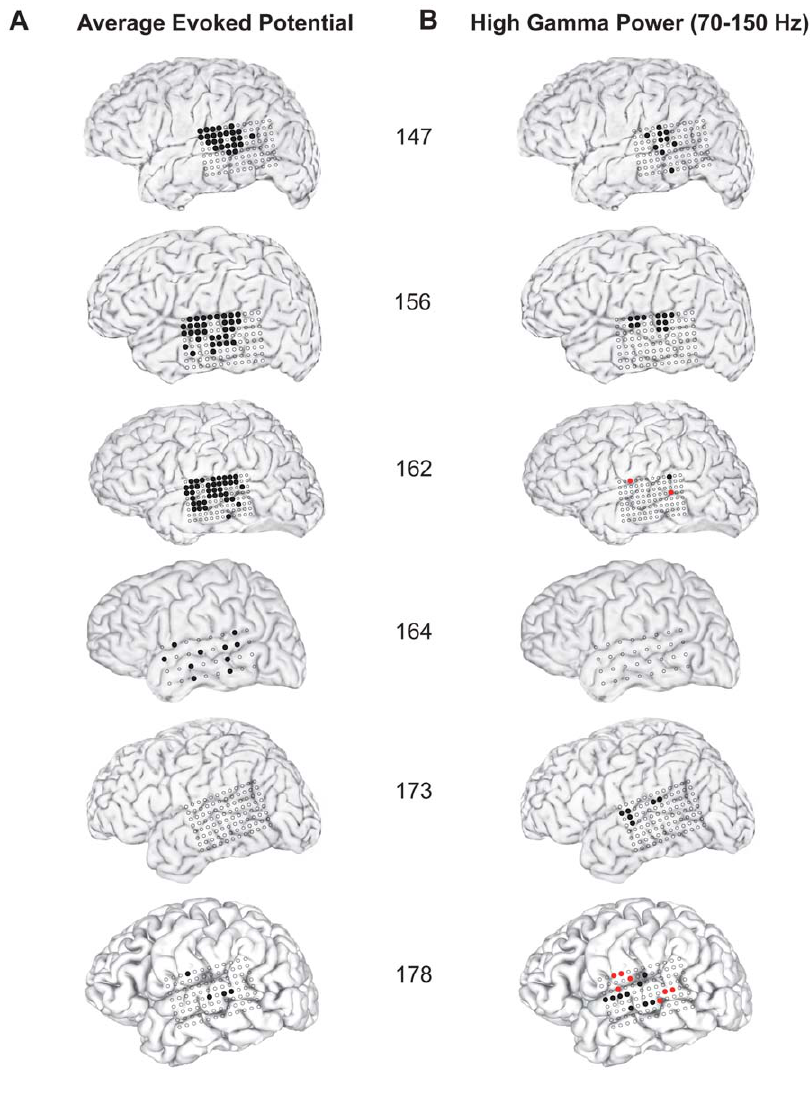
Figure 7. Summary analysis of left-sided subjects. MRI surface renderings of subjects with left-sided implants (n=6) demonstrating the locations of recording sites (filled circles) where evoked responses differed significantly during the SV versus PB conditions during the first 250 ms following stimulus onset. Contacts that demonstrated significantly attenuated AEPs during the SV condition (filled black circles, A, left column) were most often located over the lateral surface of the superior temporal gyrus. Recording sites that showed significant attenuation in the HGB power response during SV (filled black circles, B, right column) also were most often located over the superior temporal gyrus. Proportionally fewer sites demonstrated HGB responses that were significantly larger for the SV condition compared to the PB condition (filled red circles, B), and the locations of these sites did not conform to a consistent topographic pattern relative to gross anatomical landmarks of the lateral hemispheric surface.